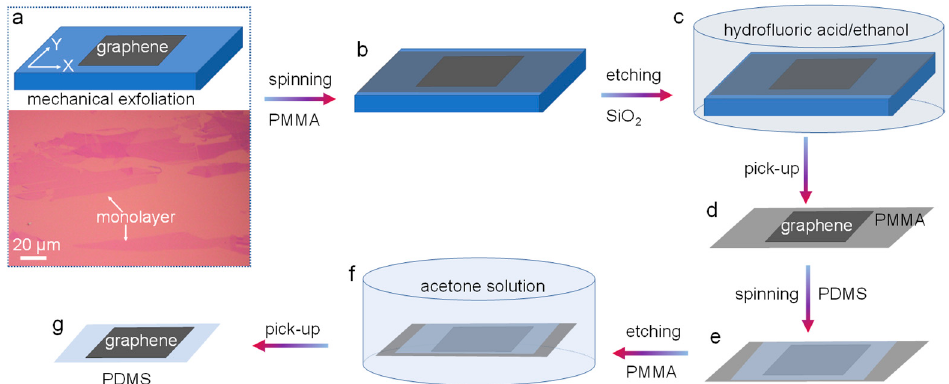
Figure 1. Schematical illustration of the process of transferring graphene to PDMS film. ( a ) Top panel, mechanical exfoliation, fabrication of few-layer graphene on Si wafer. Lower panel, optical microscopy image showing the few-layer graphene on the Si wafer. ( b ) Spinning PMMA solution on the graphene/Si wafer. ( c ) Etching SiO 2 from the Si wafer using a mixture of 5%–10% hydrofluoric acid and ethanol. ( d ) Graphene/PMMA bilayer. ( e ) Spinning PDMS solution on the graphene/PMMA bilayer. ( f ) Etching PMMA using acetone solution. ( g ) Graphene/PDMS bilayer.